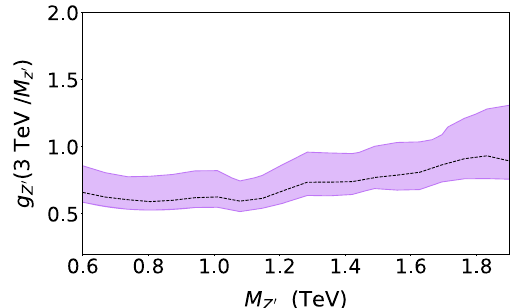
Fig. 20 Effects of theoretical uncertainties on bounds from the b - tag category of the ATLAS di-muon search with b -tagging [63].The dashed black line shows the central limit. The purple region falls between bounds obtained from upper and lower estimates of the cross- section accounting for systematic uncertainties. Toward the extreme left-hand side of the plot, our predictions become more inaccurate due / M 2 ) relative corrections to unaccounted-for O ( M 2 Z Z (cid:2)